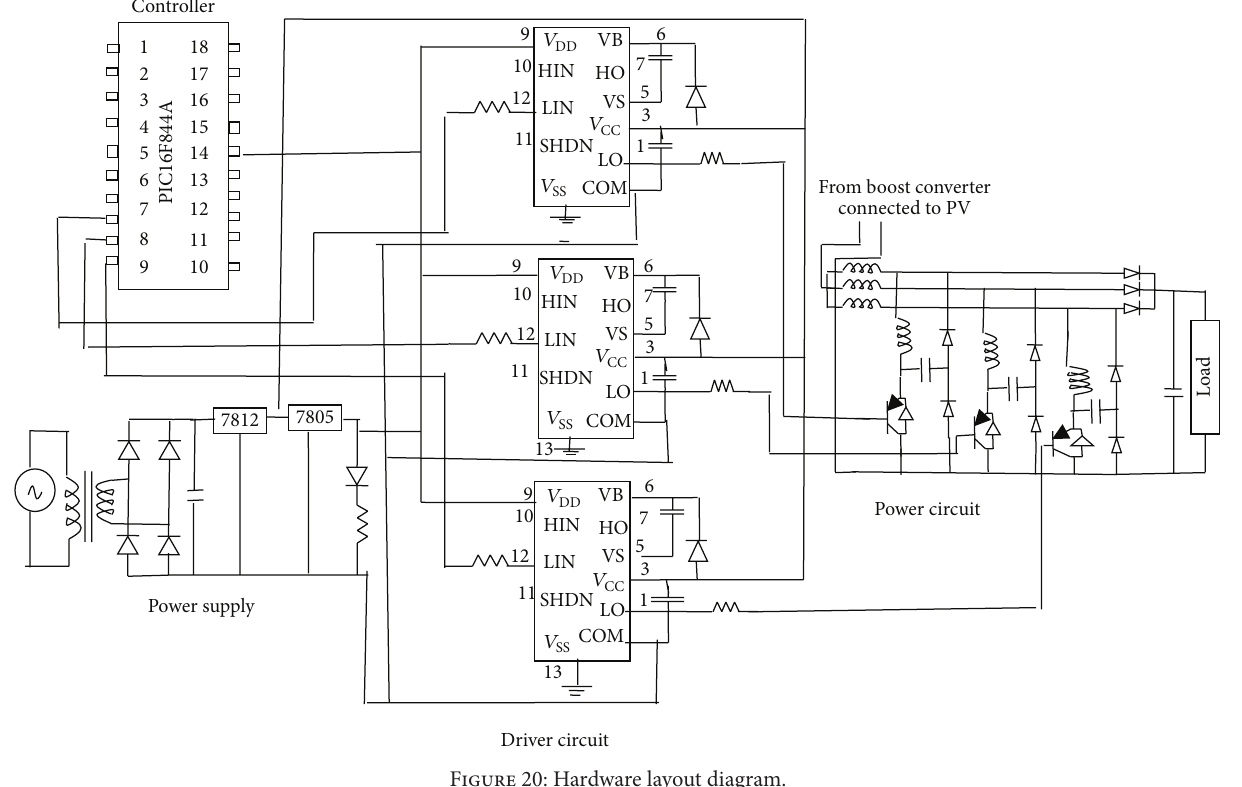
Figure 20: Hardware layout diagram.